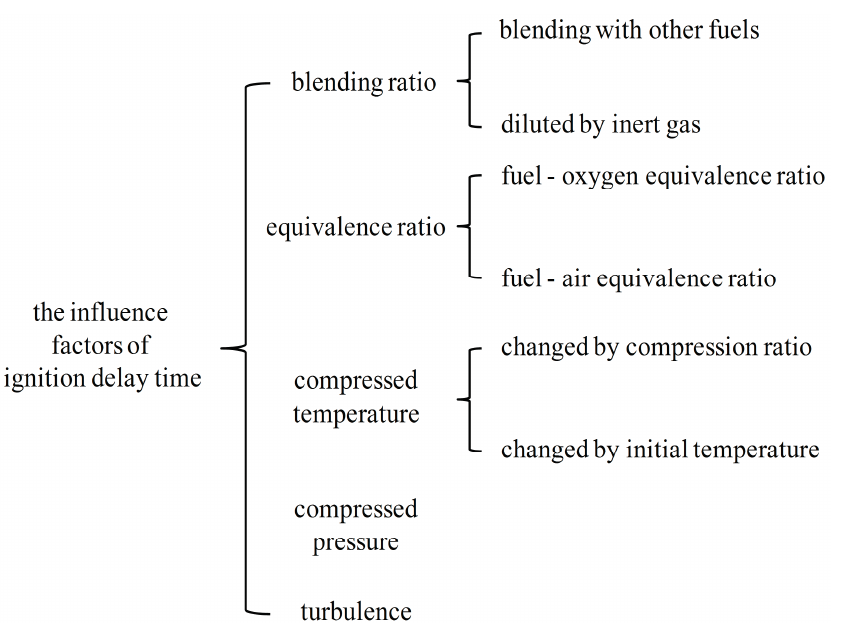
Figure 11. The influence factors of ignition delay